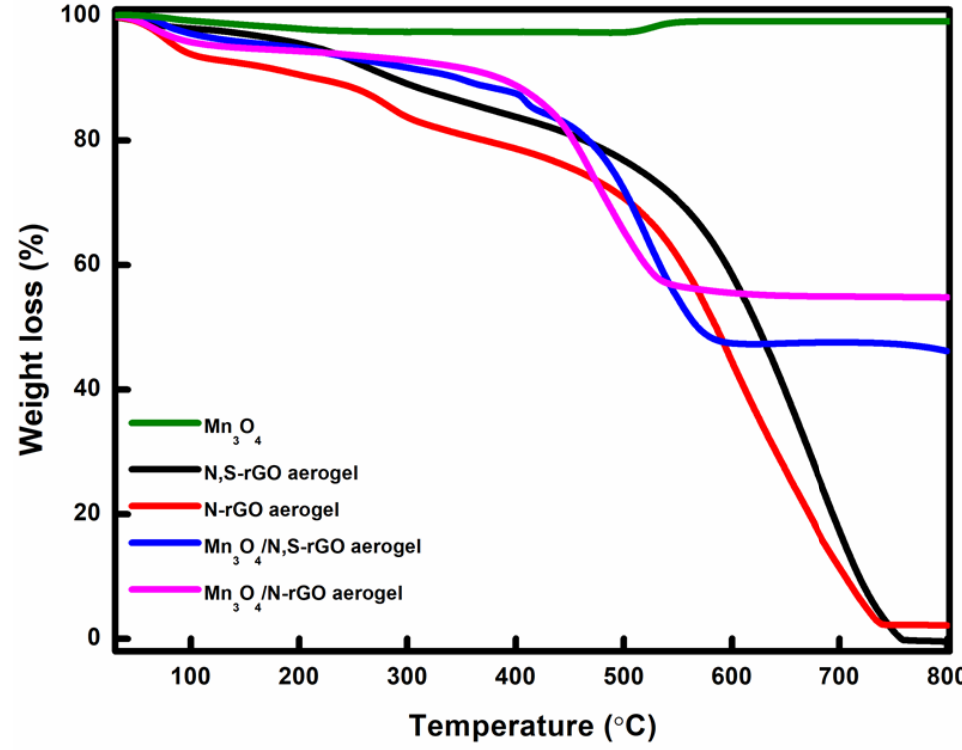
Figure 1. TGA curves of Mn 3 O 4 , N-rGO aerogel, N,S-rGO aerogel, Mn 3 O 4 /N-rGO aerogel, and Mn 3 O 4 /N,S-rGO aerogel at a heating rate of 10 °C min −1 in air.